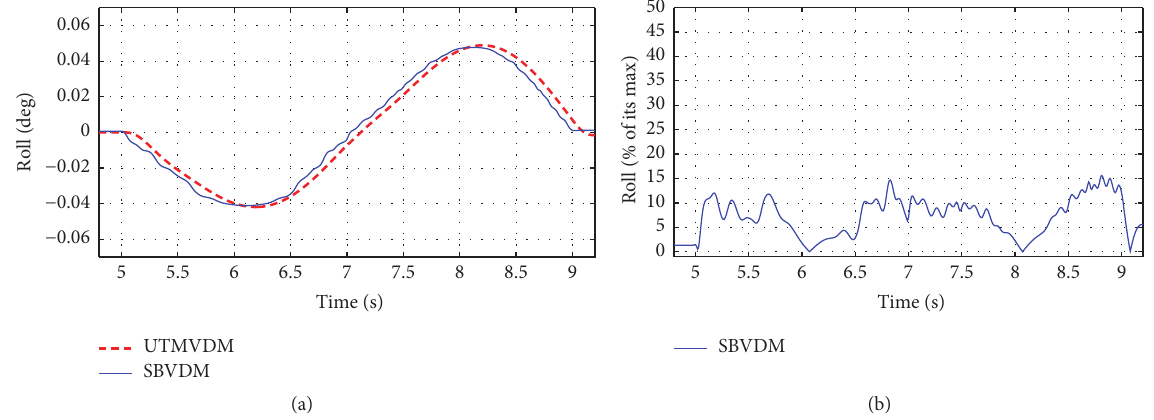
Figure 17: Vehicle roll angle and its PRE for sinusoidal steering test.